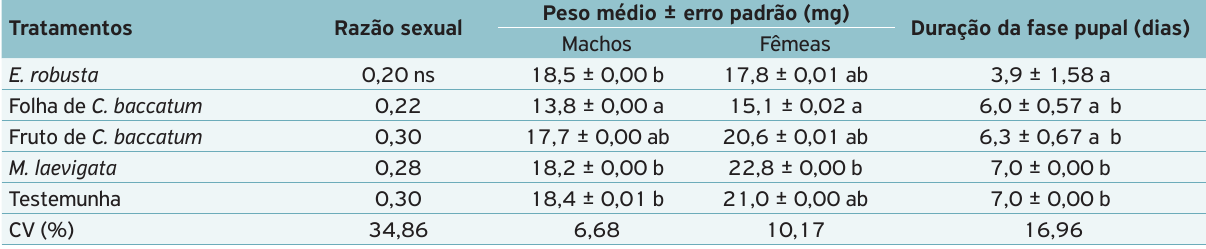
Tabela 2. Razão sexual de Spodoptera frugiperda , peso médio das pupas e duração do ciclo pupal em função de extratos